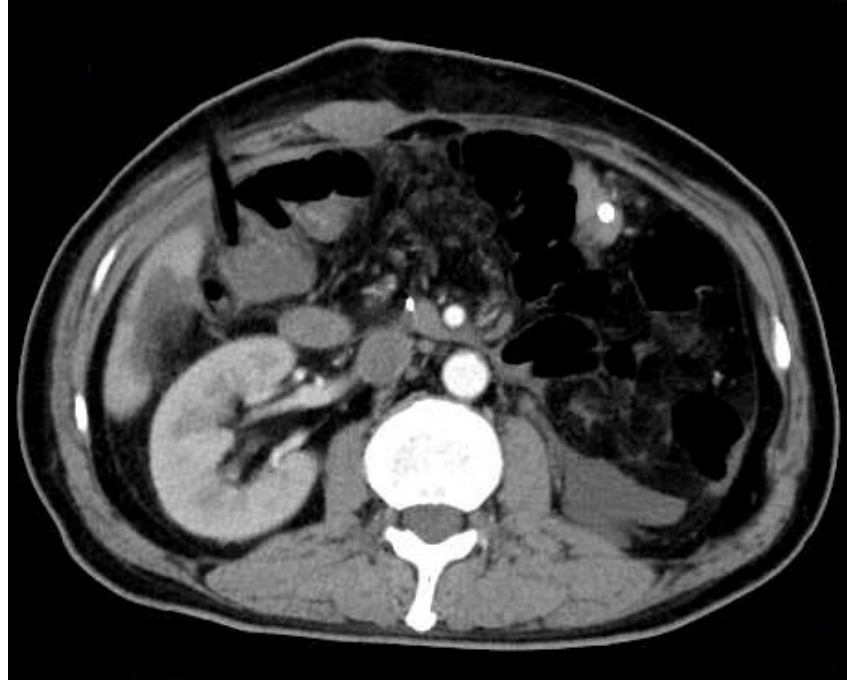
Figure 4. Abdominal enhanced computed tomography (CT) was rechecked on the fourth postoper ‐ ative day. It showed no obvious effusion or residual lesion in the abdominal cavity.